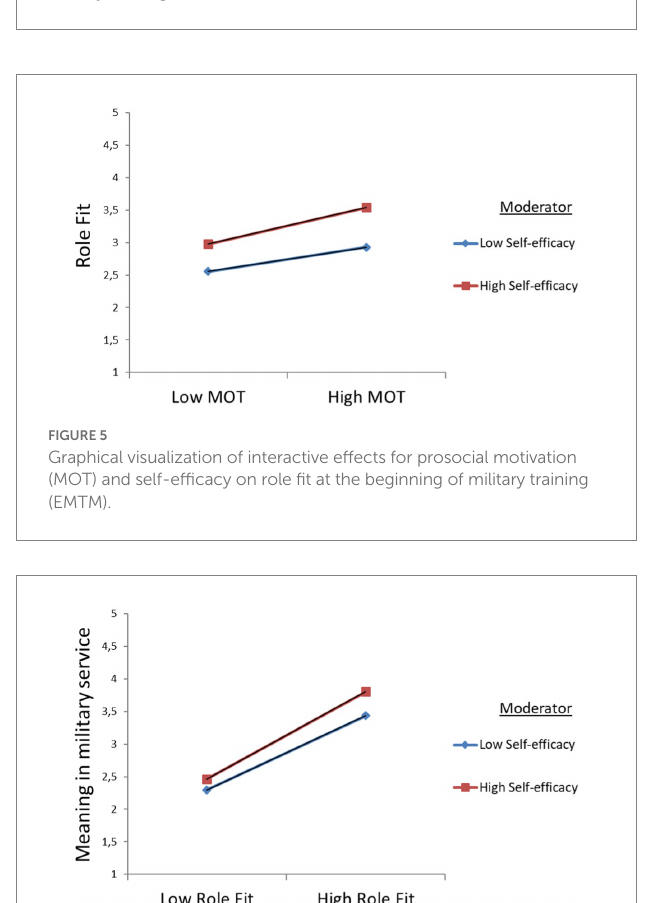
FIGURE 4 Graphical visualization of interactive effects for role fit (RLF) and self- efficacy (SEL) on meaning in military service (MMS) at the beginning of military training (BMTM).